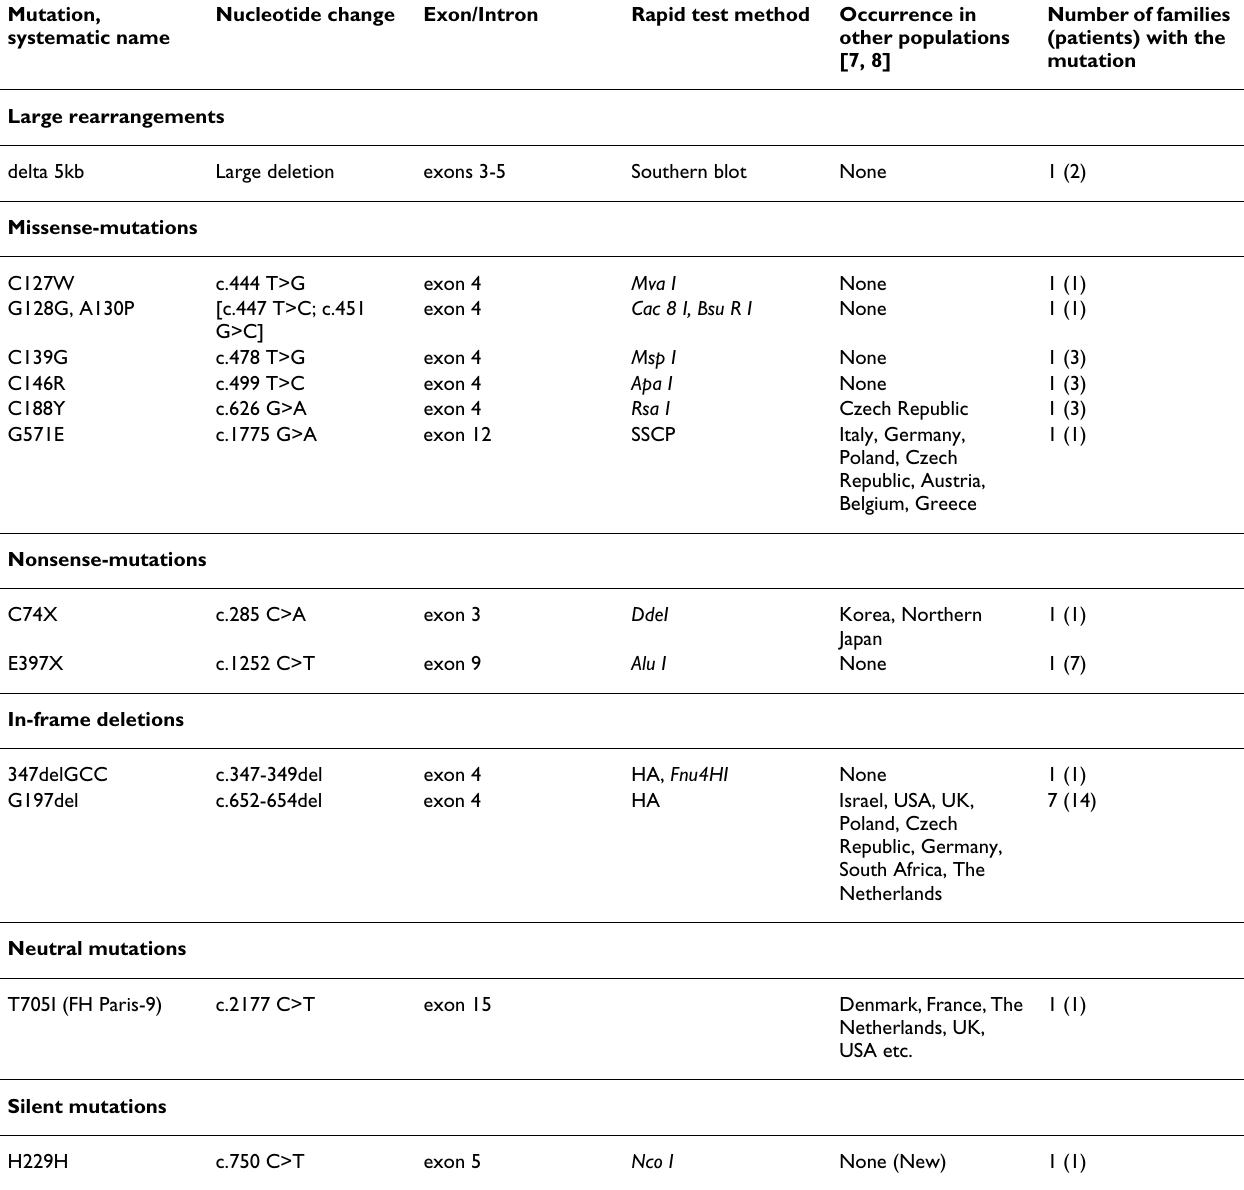
Table 3: List of the LDL receptor gene mutations reported previously from St. Petersburg, Russia [12 and References therein] Mutation, systematic